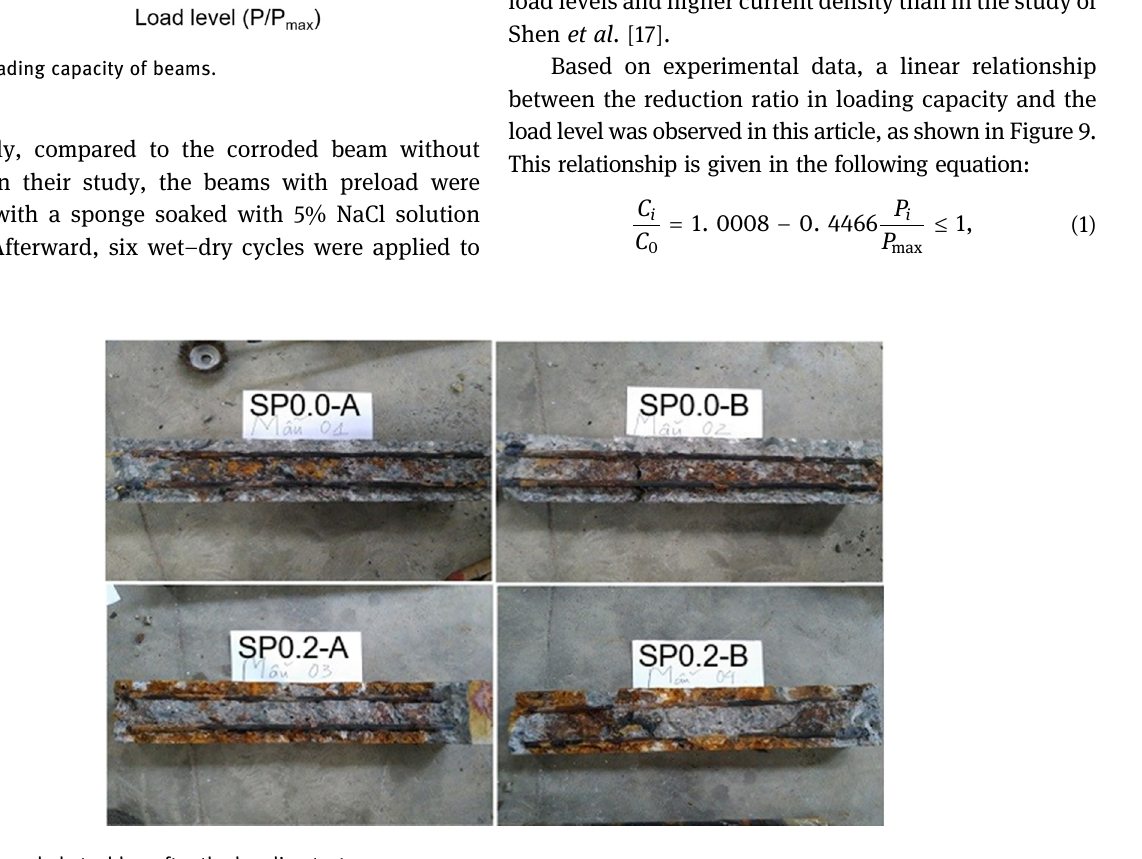
Figure 10: Corroded steel bar after the bending